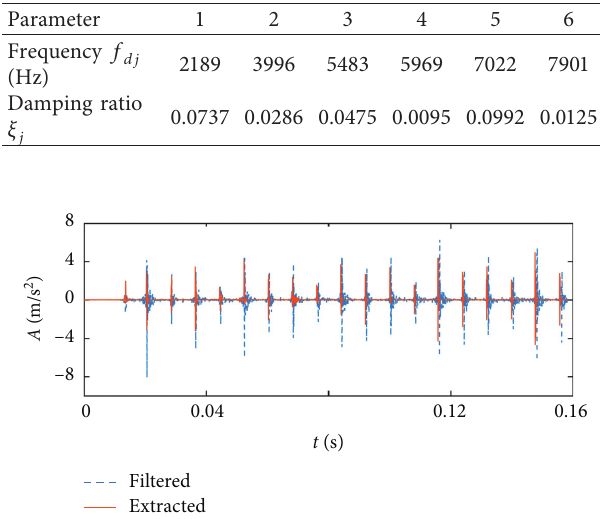
Figure 4: Vibration noiseless signal of the time domain and frequency domain under the normal state. (a) Original signal. (b) Filtered signal. Table 1: The simulation results of multiorder model parameters’ identification.